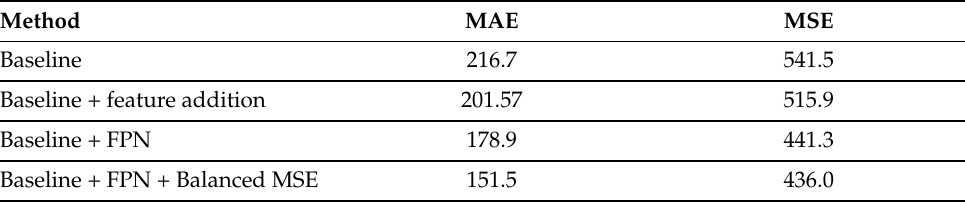
Figure 8. The images in the first row are the original input images from the Small-vehicle sub- dataset, and the second row is the ground truth.The last row is the final density estimation result of the complete SwinCounter, while the rest are the density maps generated by the incomplete models for comparison. Table 3. The experimental results of the SwinCounter under different network blocks are embodied in the MAE and MSE.